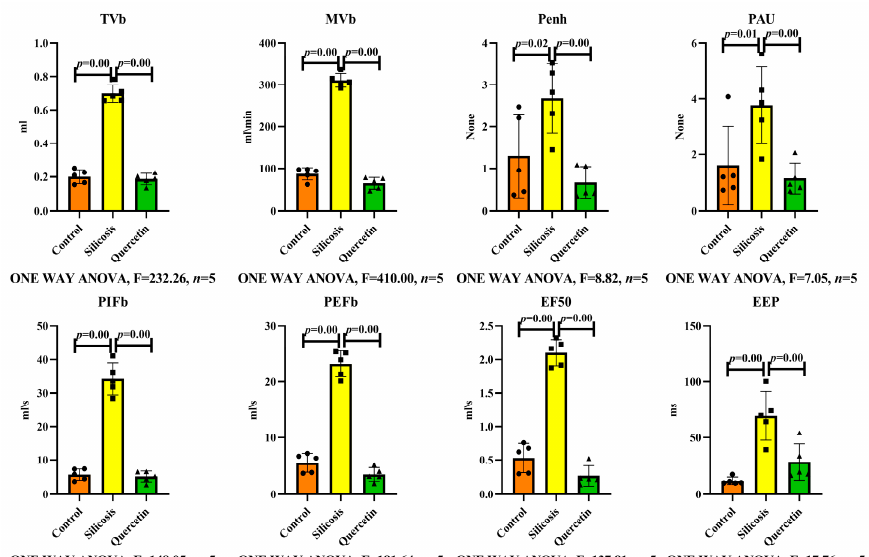
Figure 3. Lung functions of mice, measured by whole-body plethysmograph (WBP) chambers. Data are presented as the mean ± SD, n = 5 per group.